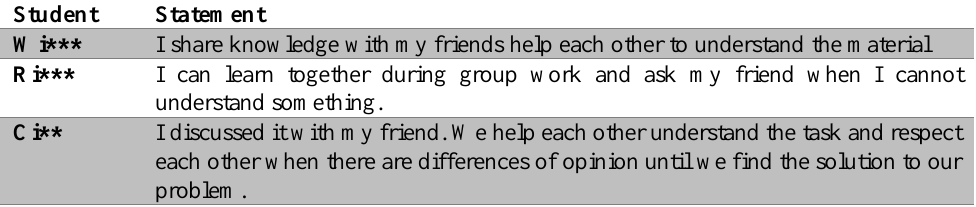
Table 4. Collaborative